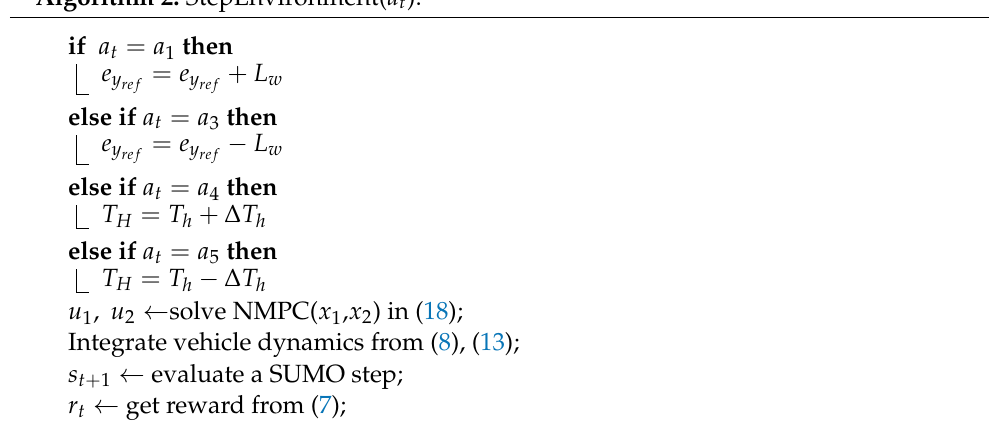
Algorithm 2: StepEnvironment( a t ).